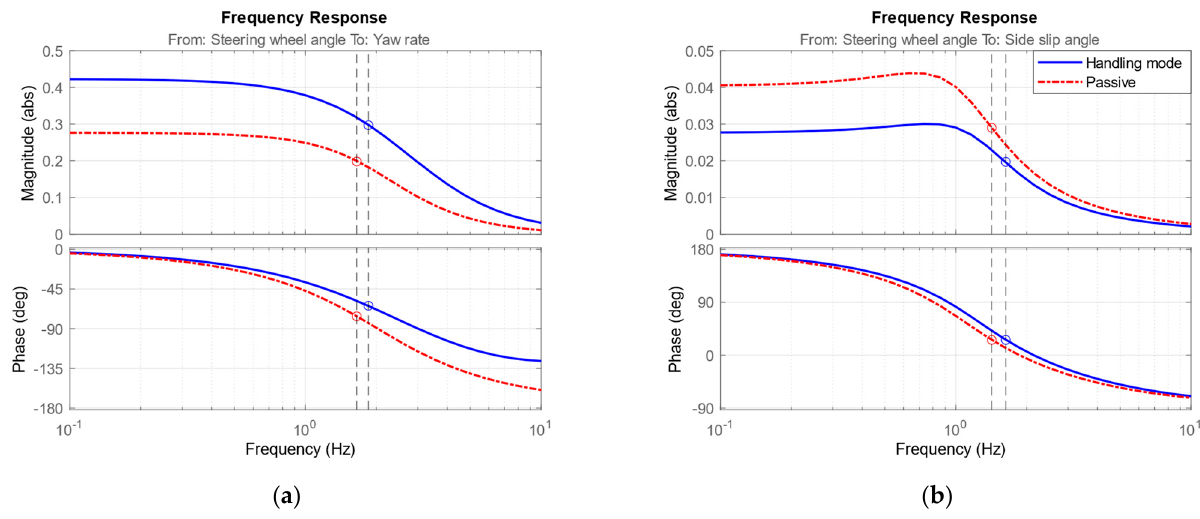
Figure 10. Frequency response in steering sine sweep test: ( a ) Yaw rate response; ( b ) Side slip angle response.